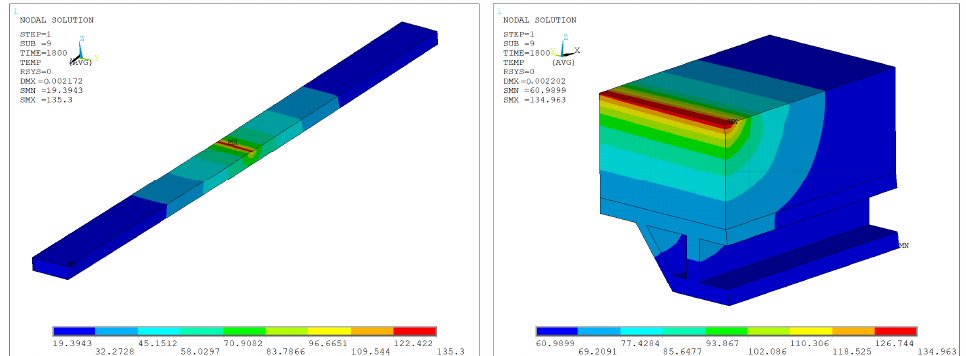
Figure 8. Temperature field in the cross-section of the composite contact strip and the aluminum reinforcing bar.